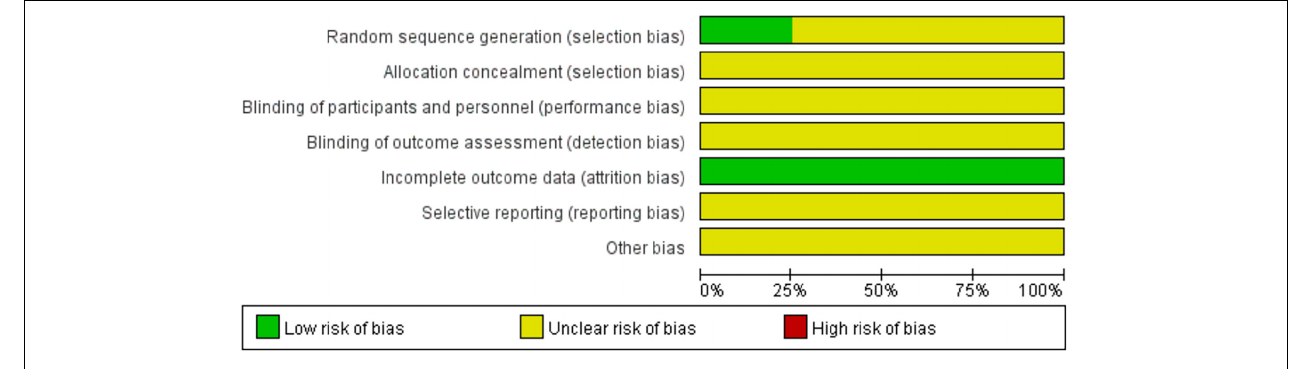
FIGURE 2 | Risk of bias graph for included studies.